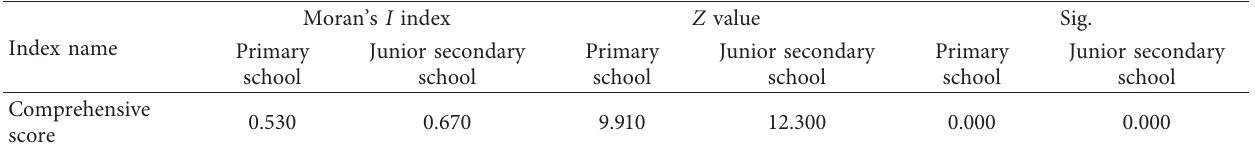
Table 6: Moran’s I